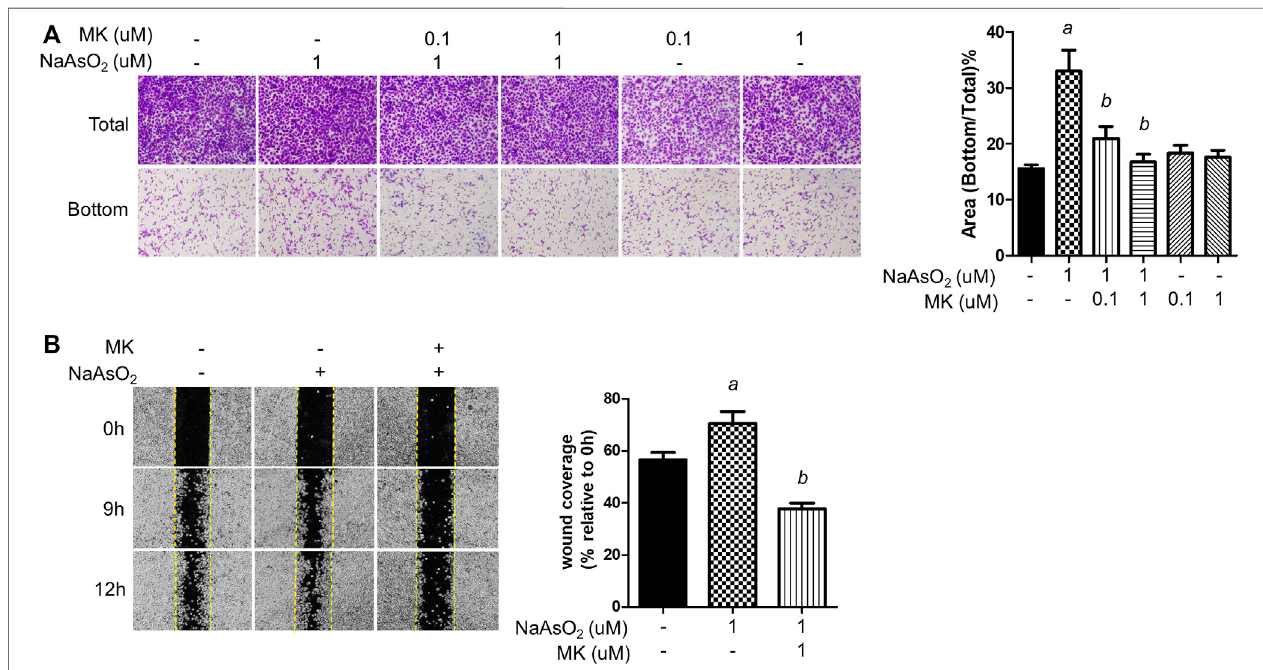
FIGURE 1 | The effect of montelukast on the arsenic-induced migration of NHBE cells. (A) Cells were treated with montelukast (MK, 0.1 and 1 µM) 2 h prior to